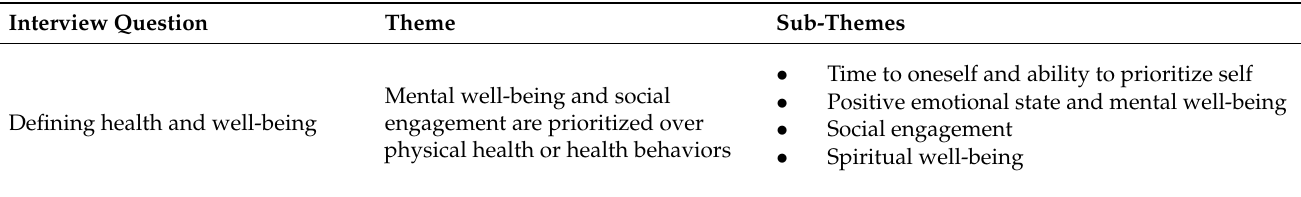
Table 1. Themes and